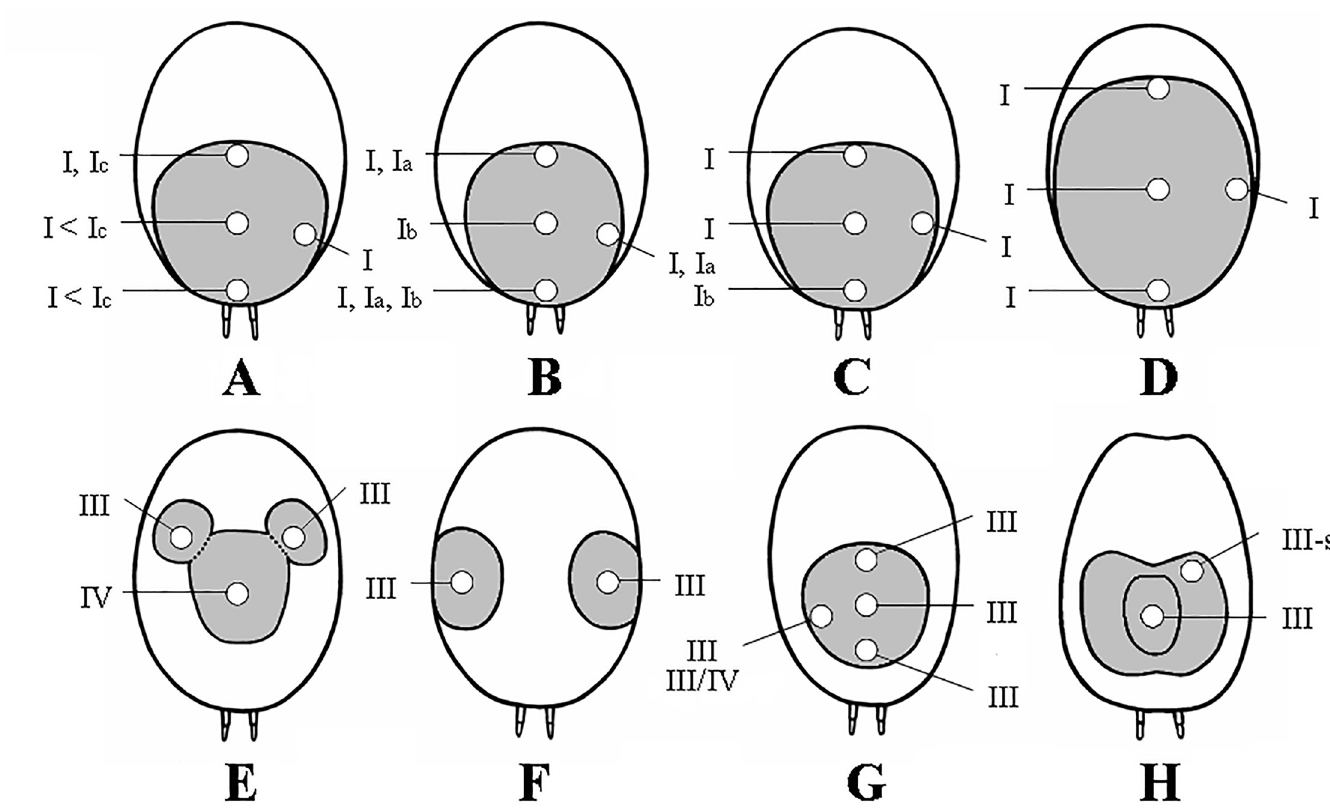
Fig 2. Distribution of urticating setae types (grey zones) on the dorsal abdomen of particular Theraphosinae. (A) Eupalaestrus larae , female from Argentina. (B) Cyrtopholis sp., male from Cuba, Guanta´namo. (C) Phormictopus auratus , female from Cuba, Holguı´n province. (D) Aphonopelma crinirufum , female from Costa Rica, Puntarenas. (E) Magulla obesa , male (according to [39]). (F) Phrixotrichus vulpinus , male from Chile. (G) Chromatopelma cyanopubescens , male from Venezuela. (H) Kochiana brunnipes , female. Abbreviations: III/IV = urticating setae of intermediate morphology between types III and IV; III-s = short type III setae, length 0.07–0.08. White circles represent the spots of sampling.